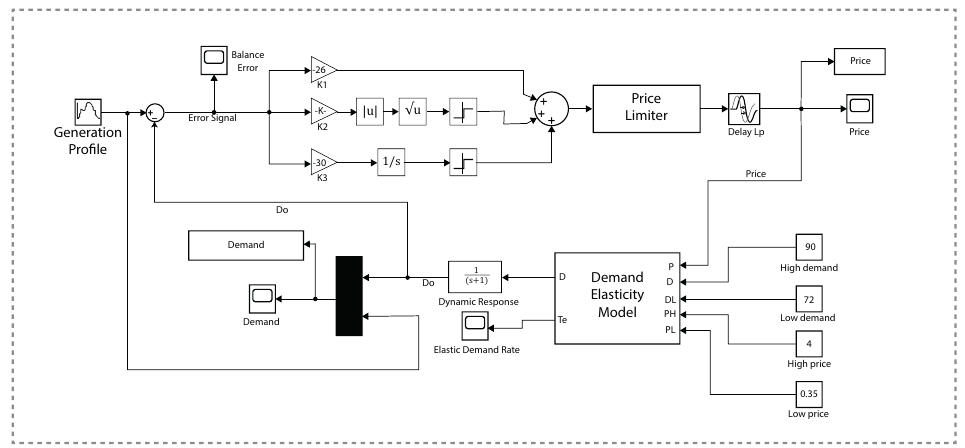
Figure 11. Simulink model formulated for the simulations of demand and price response of closed-loop elastic demand control by STSMC. Table 2. Coefficients and fractional operator values for different controller used for all